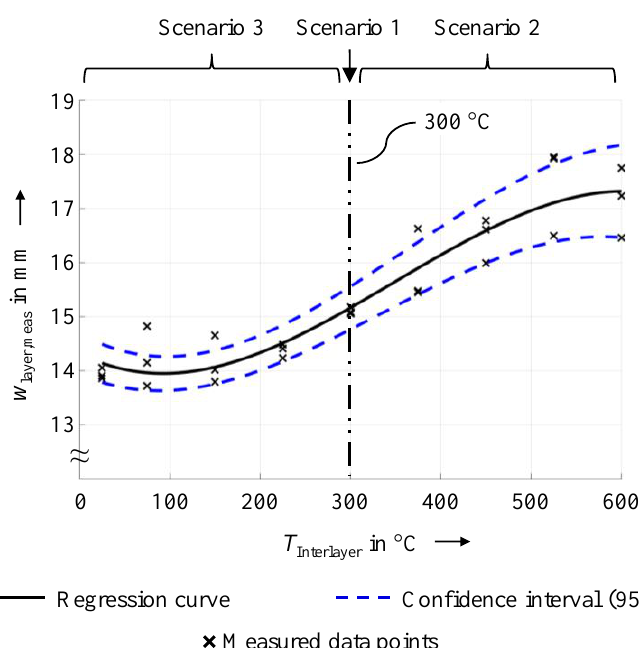
Figure 6. Correlation between measured layer widths and interlayer temperatures.